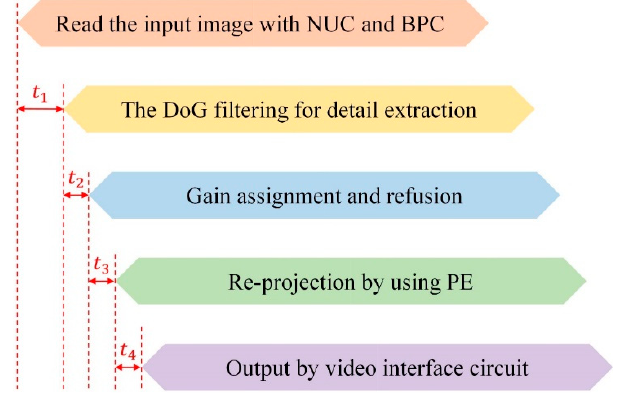
Figure 5. Framework of pipeline architecture on FPGA .